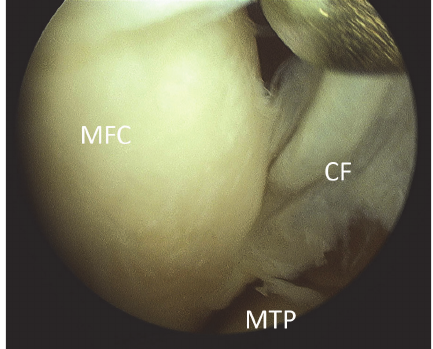
Figure 6: Arthroscopic view of the chondral flap. MFC: medial femoral condyle. CF: chondral flap. MTP: medial tibial